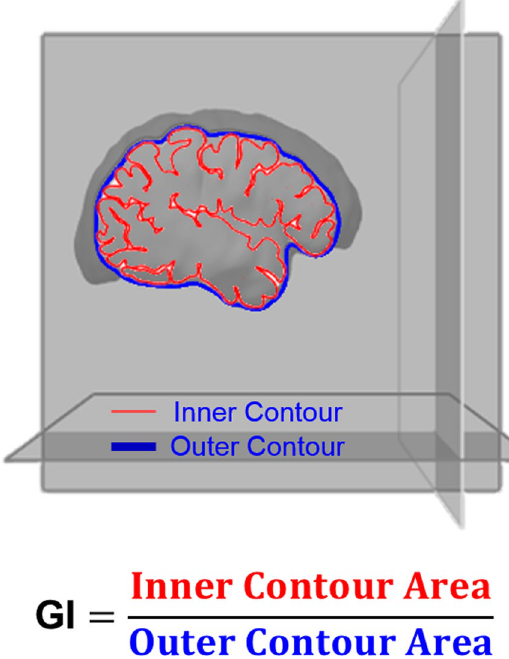
Figure 1. The illustration of cortical gyrification index (GI) as a ratio of the area of inner contour surface to the surface area of outer contour area.